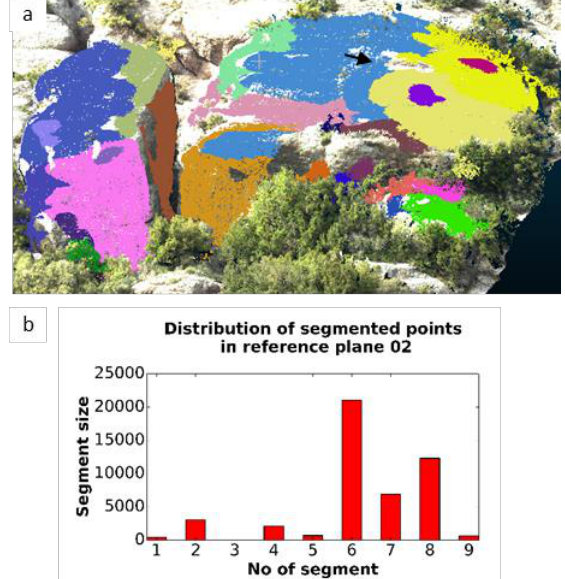
Figure 11. Result of plane segmentation for smoothed data. The black arrow marks the transcendence of the segment from reference plane 02 to 05 (a). Bar plot with number of points and distribution on segmented planes for reference plane 02